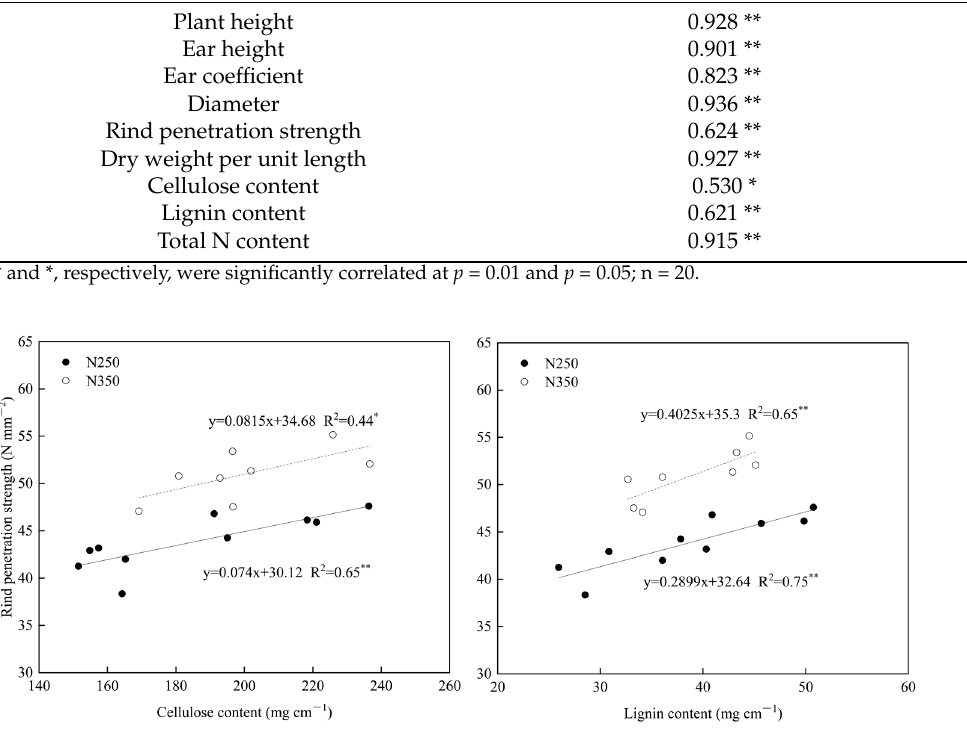
Table 4. Correlation analysis between stalk breaking force and plant morphology, stalk mechanical strength, and material content at harvest.